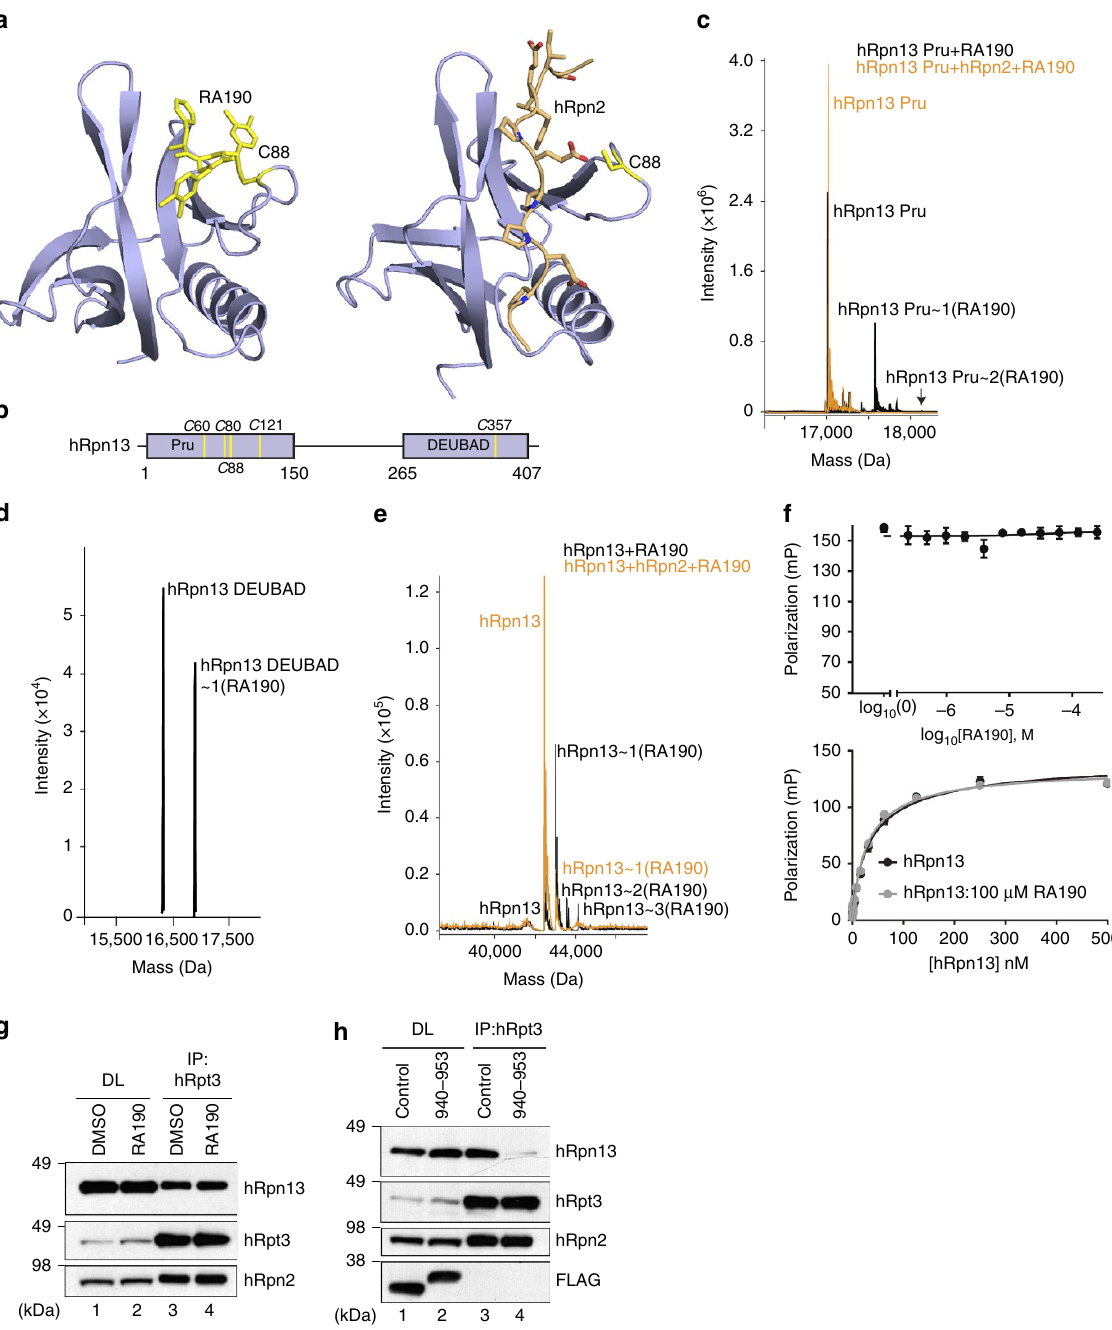
Figure 3 | hRpn2 restricts RA190 from binding hRpn13 Pru. ( a ) Model of RA190 (yellow) adducted to hRpn13 (periwinkle blue) C88 (yellow, left panel) and NMR structure of hRpn13 Pru-hRpn2 (940–953) (right panel). hRpn2 is orange with nitrogen and oxygen in blue and red, respectively. ( b ) Schematic representation of hRpn13 domains with locations of cysteines indicated. ( c – e ) LC-MS analysis of 2 m M hRpn13 ( c ) Pru (black), ( d ) DEUBAD or ( e ) full- length protein (black) or with equimolar hRpn2 (940–953) (orange) following 2h of incubation with 20 m M RA190. ( f ) FP values for 30nM hRpn13 Pru incubated serially for 30min with indicated RA190 concentrations and 10nM FITC-hRpn2 (940–953) (upper panel). FP values for 100 m M RA190 or 2% DMSO incubated serially for 30min with varying concentrations of full-length hRpn13 as indicated (lower panel), followed by 10nM FITC-hRpn2 (940-953). In both cases, FP values were measured in triplicate and corresponding values for FITC-hRpn2 (940–953) alone were subtracted from the measurements. The final values for each panel were plotted against RA190 concentration and fit using the log(inhibitor) versus response–variable, four parameter model (upper panel) or hRpn13 concentration by a Hill slope model (lower panel). The s.d. of each data point to the average value is displayed by error bar. ( g ) HCT116 cells were treated with 1 m M RA190 for 24h or DMSO (as a control) and the cell lysates immunoprobed (DL) or subjected to immunoprecipitation with anti-hRpt3 antibodies before immunoblotting as indicated. ( h ) Cell lysates (DL) or immunoprecipitates derived by anti-hRpt3 antibodies from HCT116 cells expressing FLAG-EGFP (control) or FLAG-EGFP-hRpn2 (940–953) were subjected to immunoprobing, as